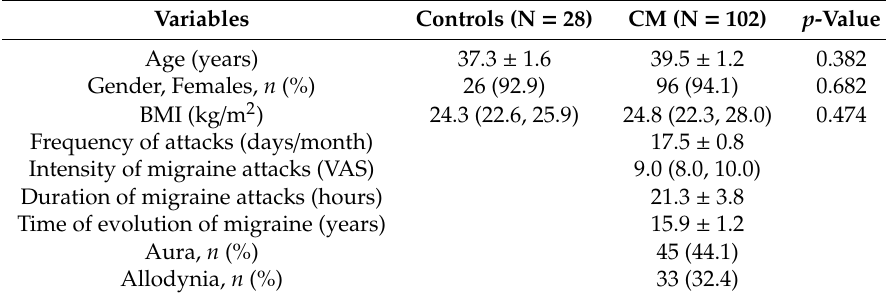
Table 1. Baseline characteristics of the study population.